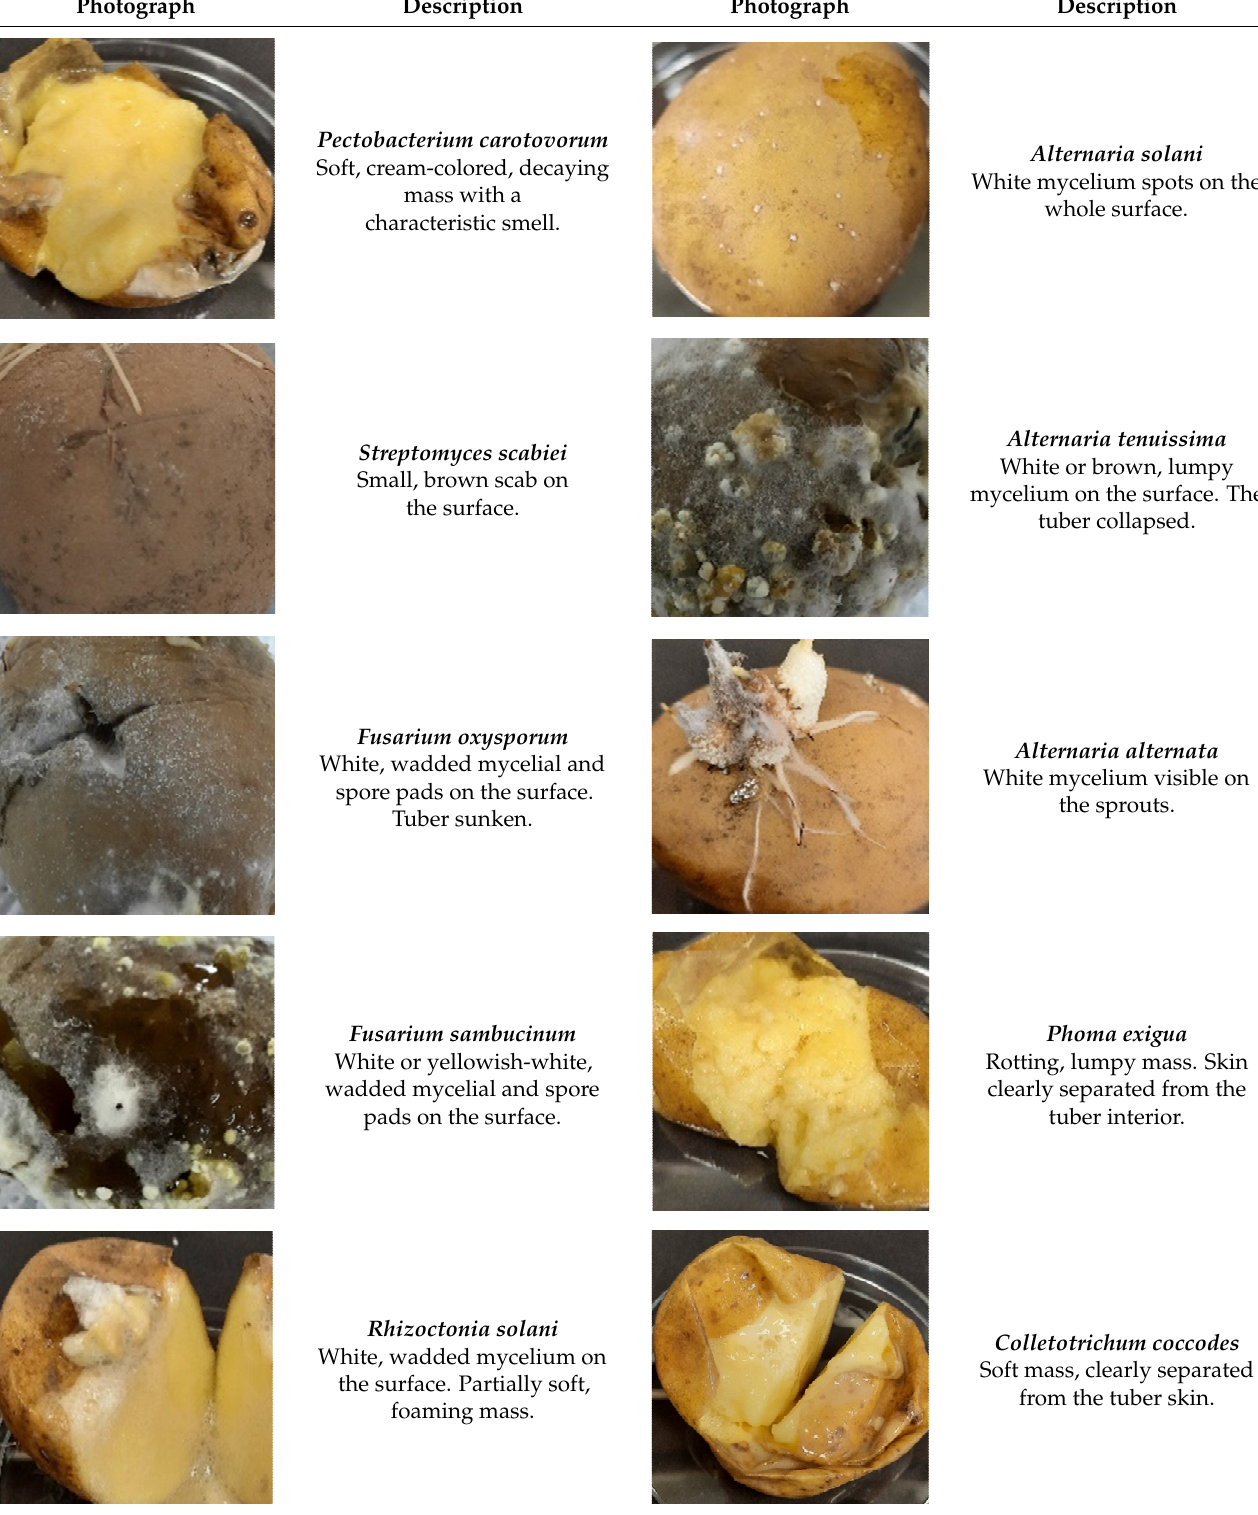
Colletotrichum coc- codes Colletotrichum Soft mass, clearly sep- arated from the tuber skin.